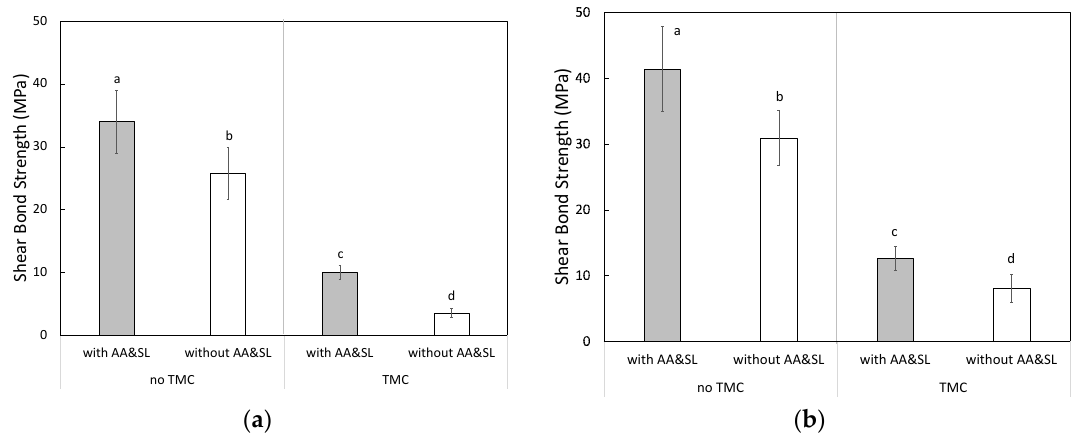
Figure 5. Shear bond strength of the specimens for ( a ) Shofu HC Hard (SH) and ( b ) Cerasmart 300 (CE), as illustrated in Figure 1c. The vertical error-bars indicate standard deviations. The different letters indicate a significant difference between the groups ( p < 0.05, Tukey test, n = 12). AA&SL: alumina air-abraded and silanized specimen. TMC: 20,000-thermocycled specimen. No-TMC: 0-thermocycled specimen.